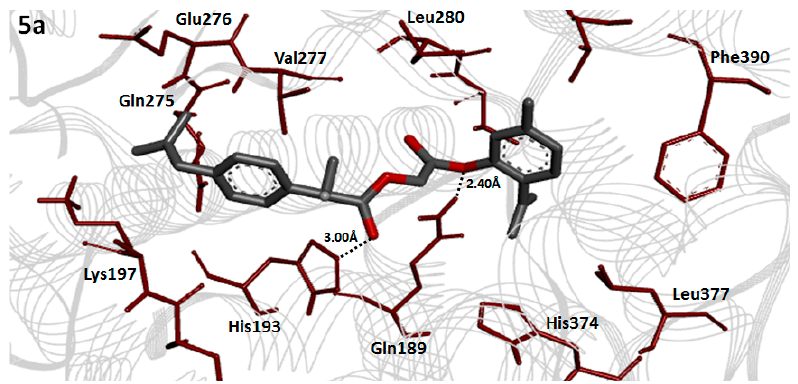
Figure 4. Docking interactions of ( 5a ) with receptor. The COX-2 protein chain is highlighted in light grey color in wire format. The dark grey color showed the ligand structure while the embedded red colors showed oxygen moiety. The binding pocket interacted residues are highlighted in dark red color and black dotted lines justify the hydrogen bondings. Two hydrogen bonds were observed with GLN189 and HIS193 at a distance 2.40 and 3.00 Å, respectively.